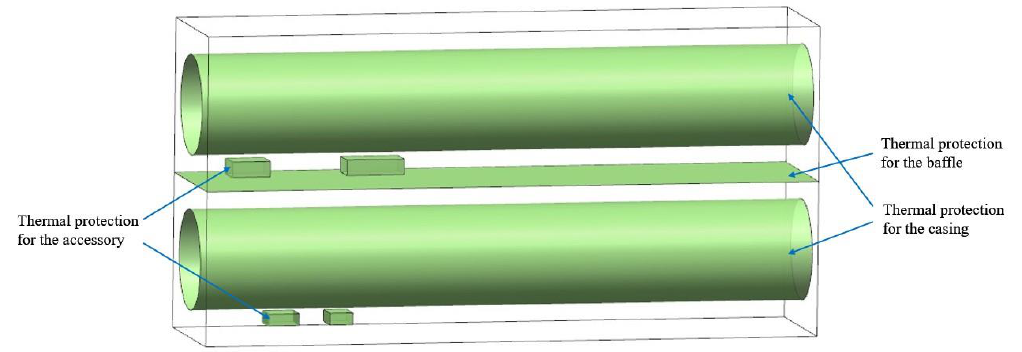
Figure 22. Temperature of accessory 2 when the baffle and accessory were thermally protected.